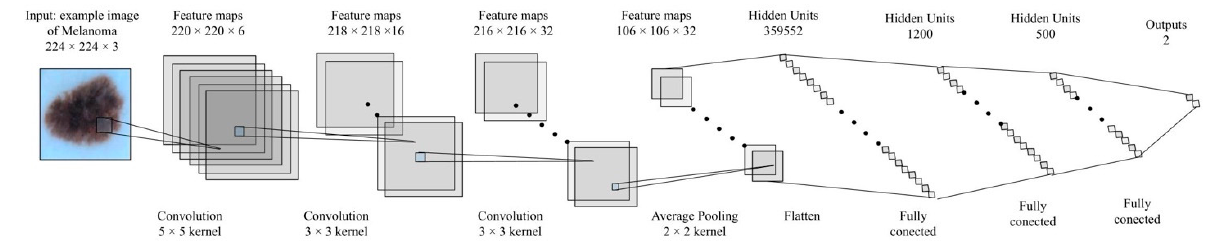
Figure 6. Convolution network structure based on real numbers for this study.